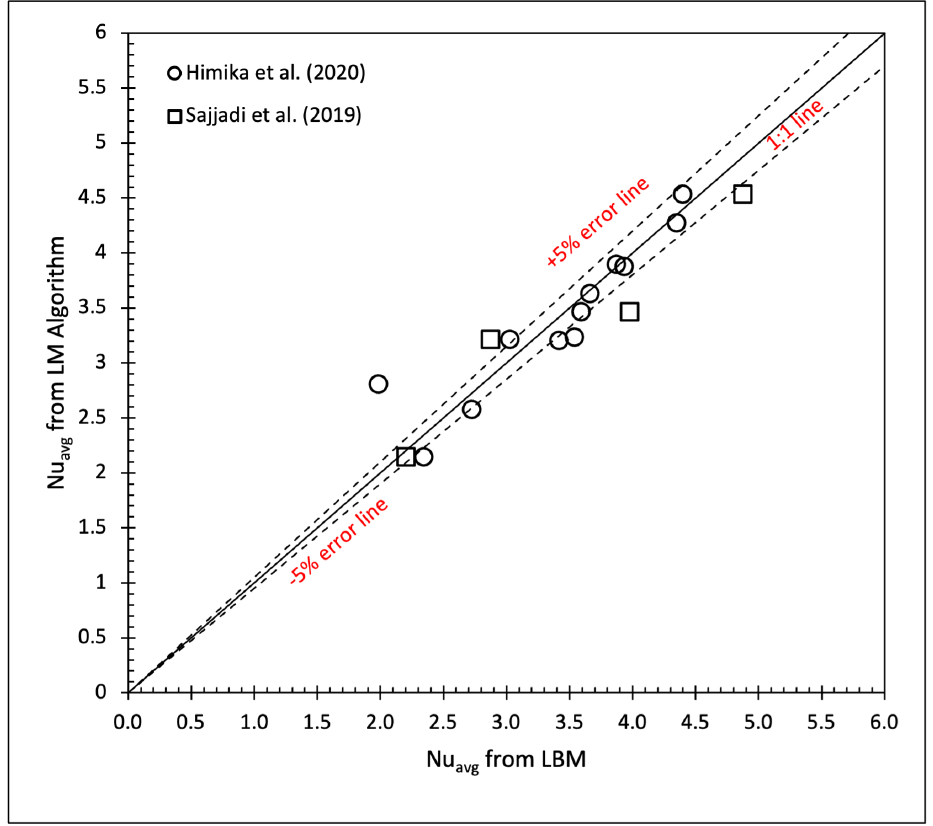
Figure 10. Fitting parametric development over a planar surface to predict Nu under constant Ra = 10 5 , θ = 60, and Da = 10 − 1 [18,62]